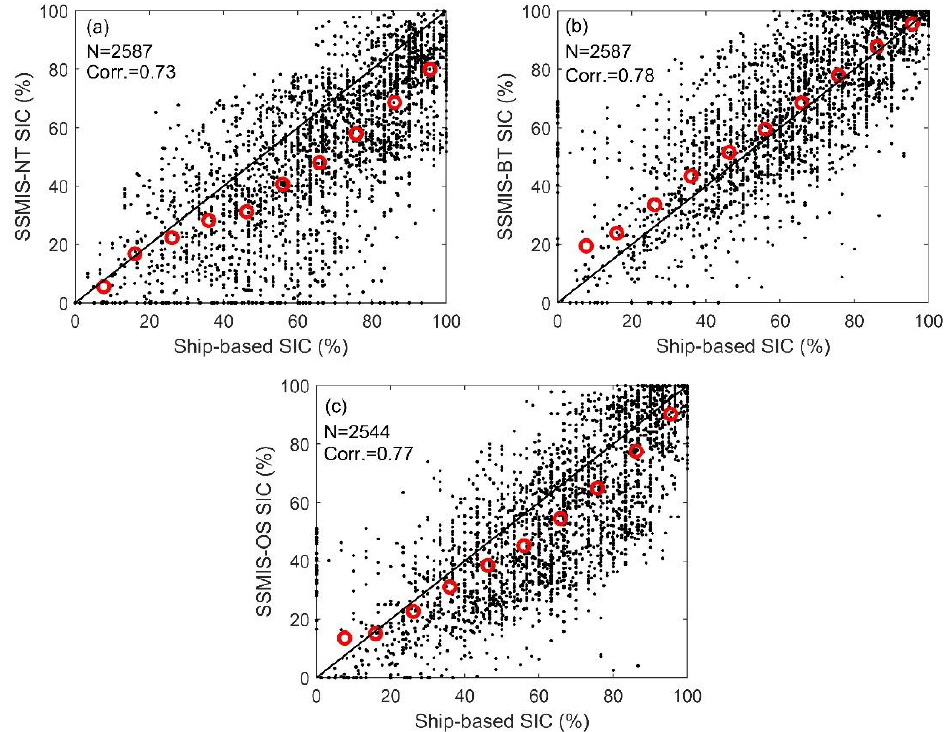
Figure 8. Scatterplots of the SSMIS-based SICs versus the ship-based SIC along all of the trajectories of the 60 Arctic cruises: ( a ) SSMIS-NT, ( b ) SSMIS-BT, and ( c ) SSMIS-OS. The black lines are 1:1 relationship lines and the red circles represent mean results for every 10% interval. Table 2. The biases, RMSEs, and correlation coefficients (Corr.) of the three SSMIS-based products on two different scales, with different sample numbers.